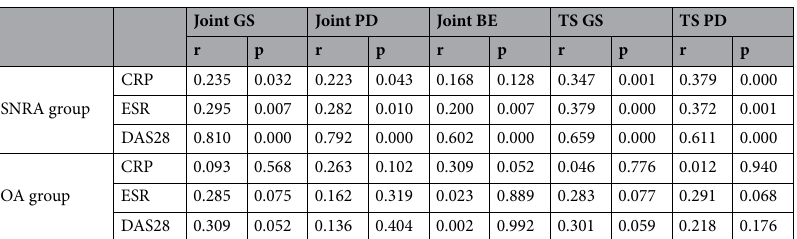
Joint GS Joint PD Joint BE TS GS TS PD